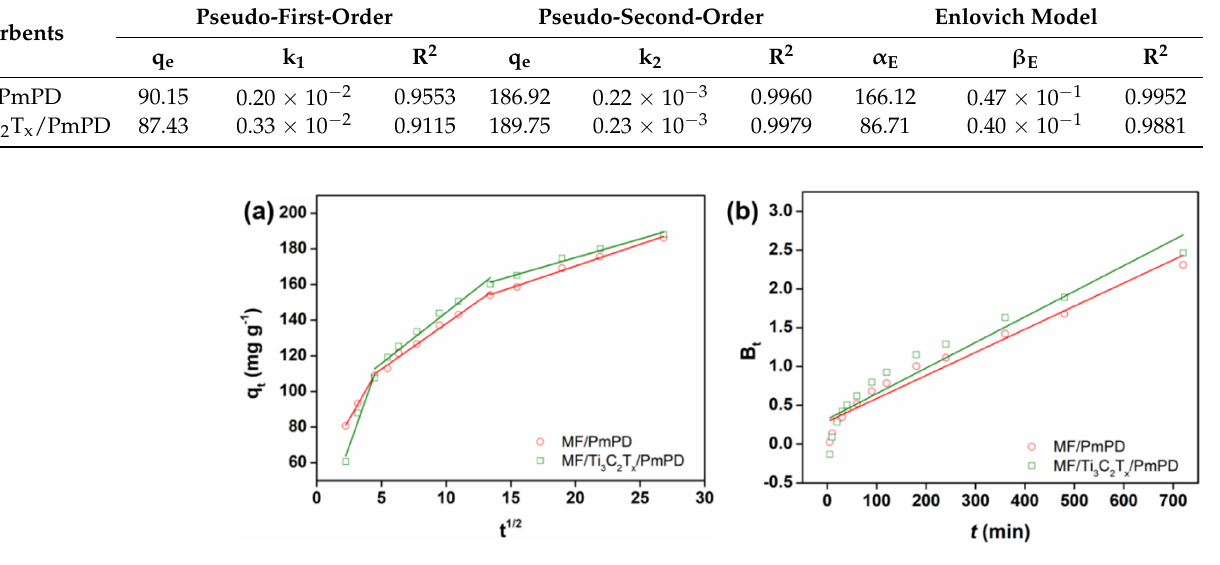
Figure 11. Linear fitting of intraparticle diffusion ( a ) and Boyd model ( b ) of Cr(VI) adsorption by MF/PmPD and MF/Ti 3 C 2 T x /PmPD. Table 4. The fitted parameters of intraparticle diffusion model and Boyd model of Cr(VI) adsorption by MF/PmPD and MF/Ti 3 C 2 T x /PmPD.